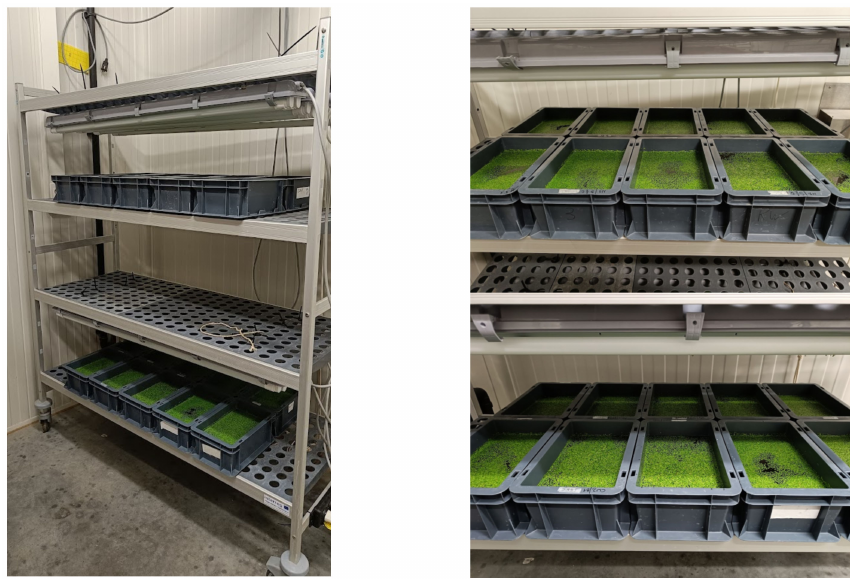
Figure 7. Picture of the growth rack used for all tray experiments, with 10 PET containers and 4 parallel TL-lights per